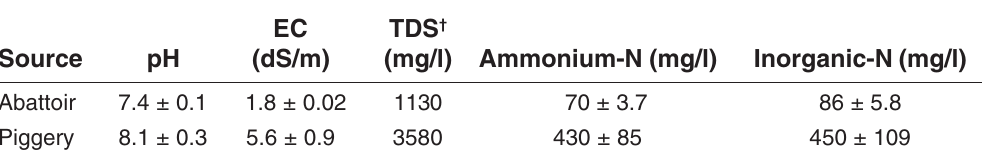
Selected Characteristics of Effluent from Waste